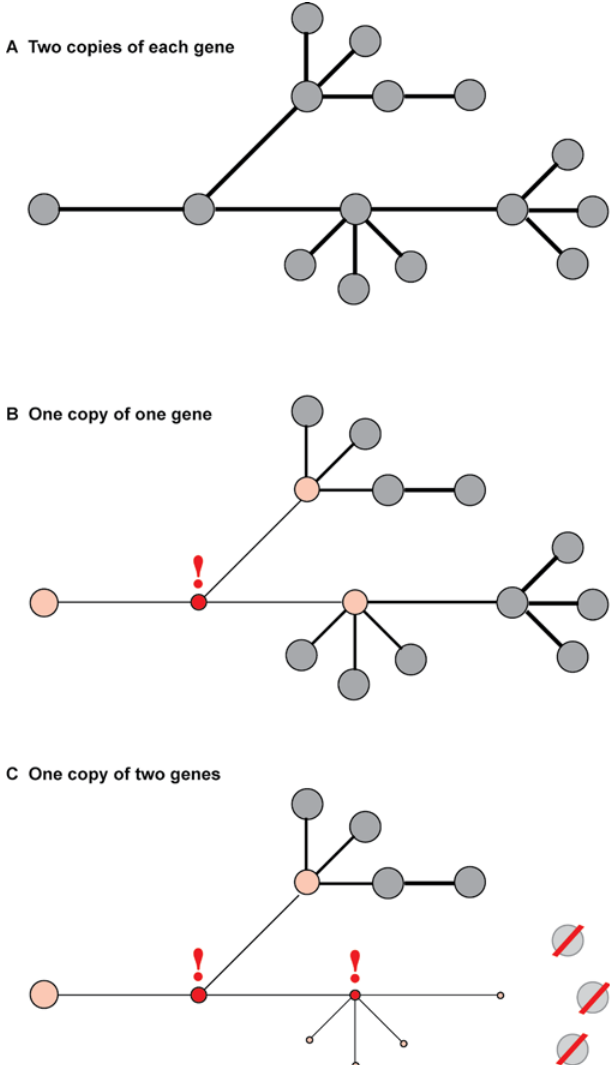
Figure 1. Network Cartoon (A) In this simple diagram, genes (circles) and regulatory connections (lines) are shown. (B) Reducing the dose of one gene (red exclamation point) perturbs the immediately connected genes (rose), but does not collapse the network. (C) Reducing the dose of two genes result in the loss of one part of the network (red